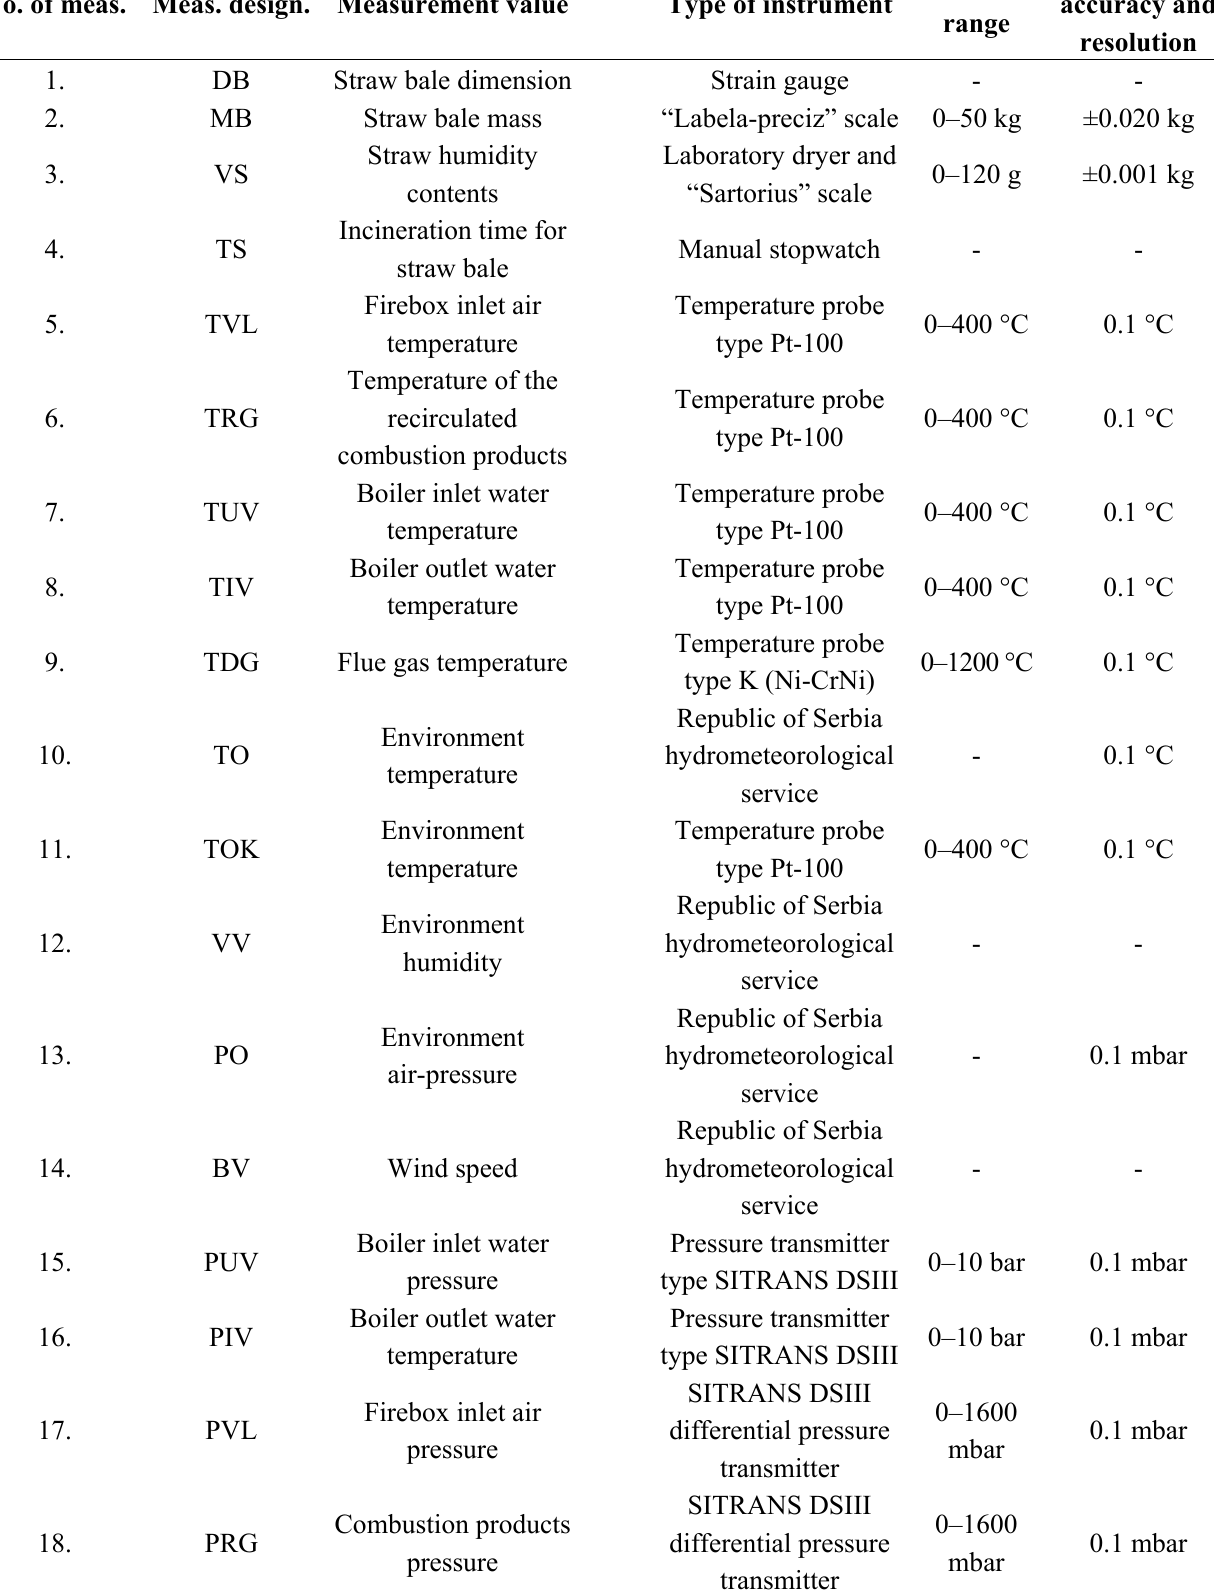
Table 1. Summary of measurement points and instruments. No. of